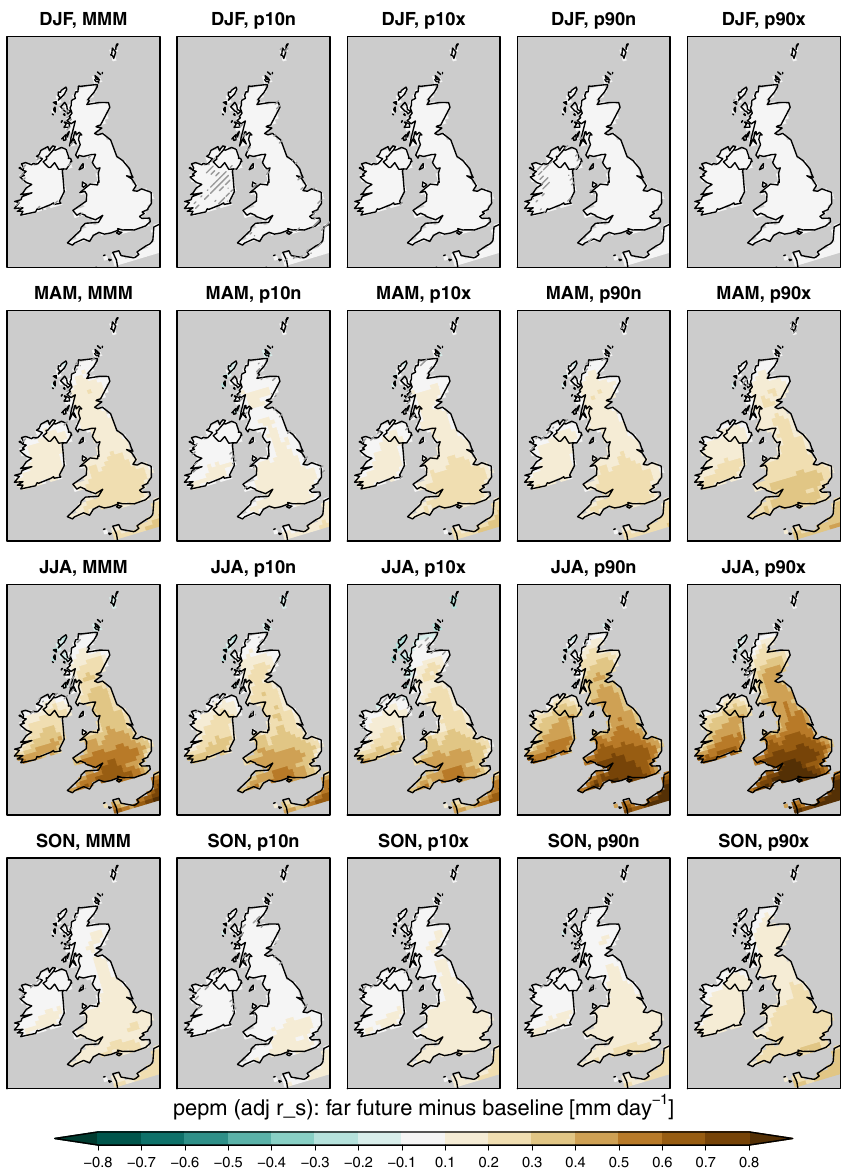
Figure 14. Same as Fig. 10 but for E pot (with stomatal resistance adjusted to CO 2 concentration; see Fig. S17 for the changes when stomatal resistance is kept constant). Hatching indicates grid cells with statistically non-significant changes at the 95% level according to a two-sided T test. The corresponding figures for the near-future time slices are shown in Figs. S18 and